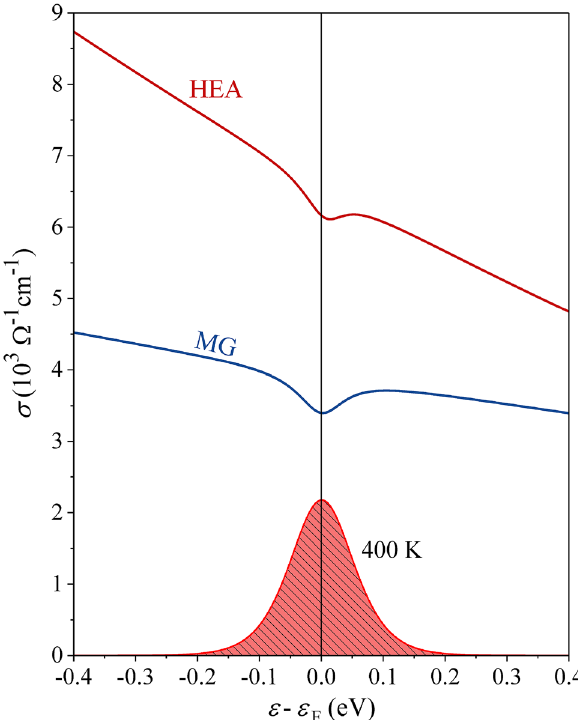
Figure 6. Spectral conductivities σ HEA (ε) and σ MG (ε) , determined from simultaneous fitting of the electrical resistivity ρ( T ) and the thermopower S ( T ) (the sets of fit parameters are given in Supplementary Table S2). The bell-shaped derivative of the FD function, − ∂ f /∂ε , at 400 K is shown at the bottom of the graph (its vertical scale does not conform to the σ(ε)